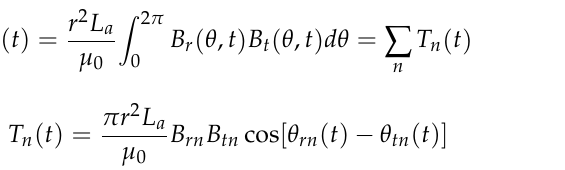
Figure 8. Comparison between analytical results and FEA of rated load air-gap flux density.